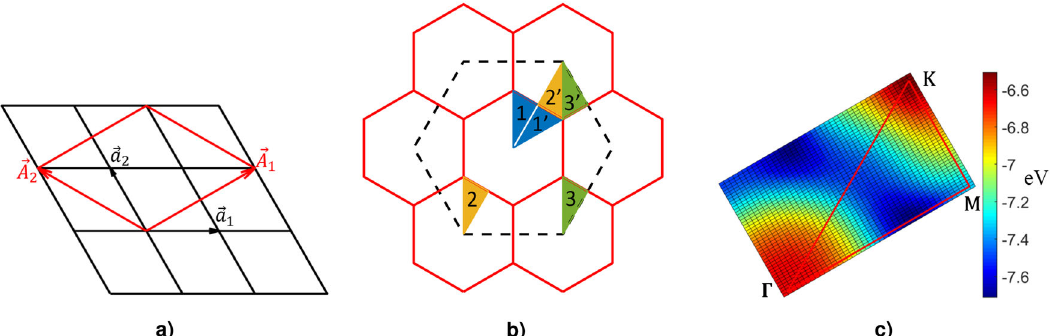
ffiffiffi p ffiffiffi p ´ 3 3 supercell. The